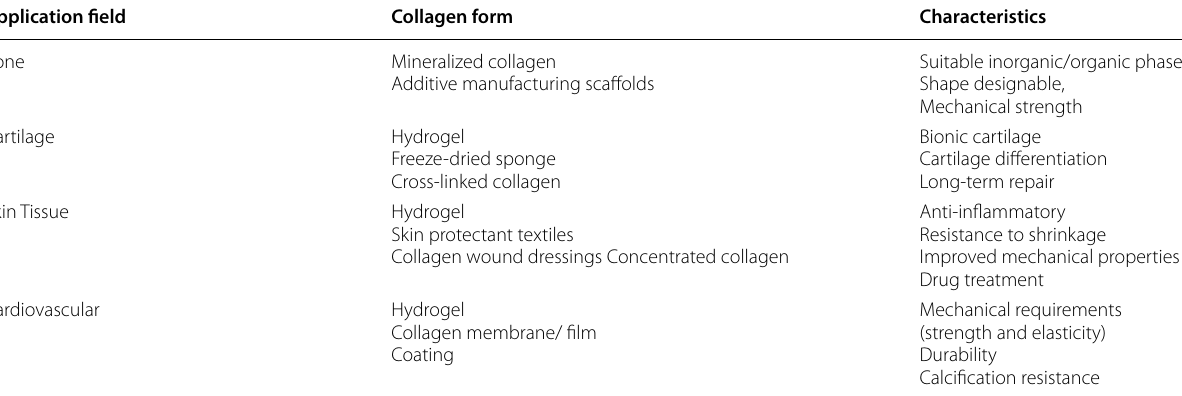
Table 3 Adaptive morphology and characteristics of collagen in different application fields Application